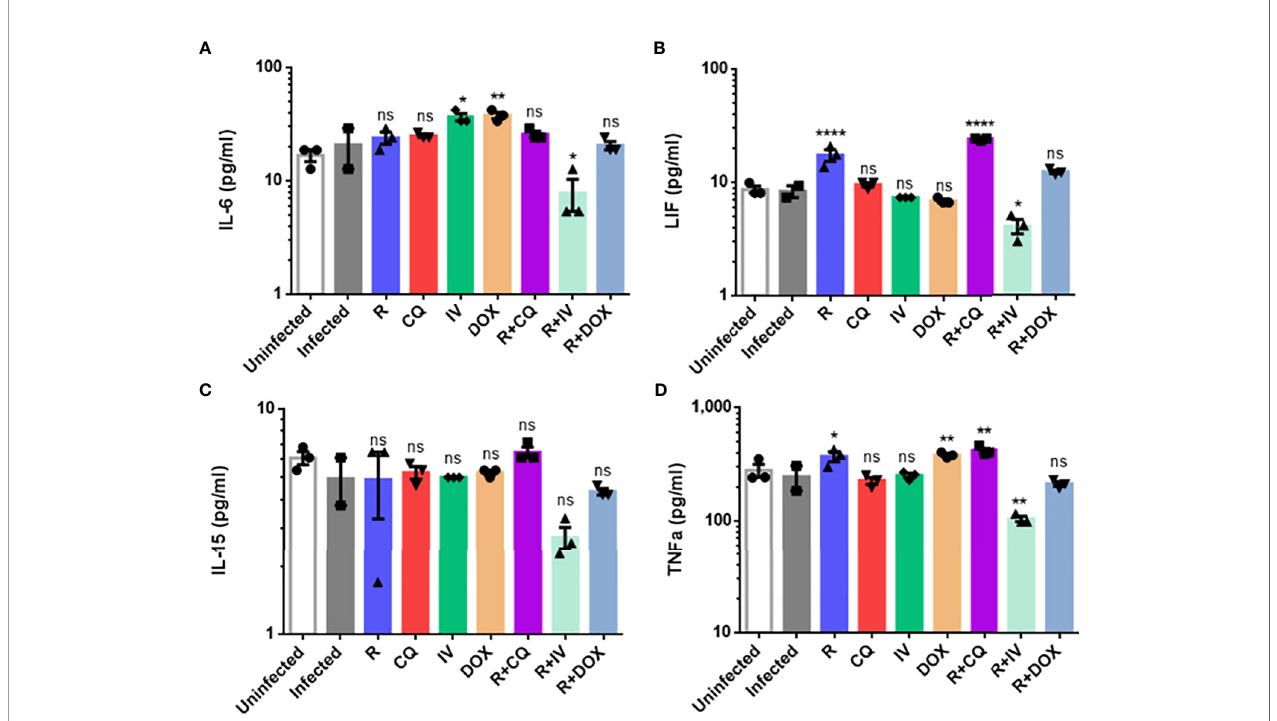
FIGURE 3 | Cytokine protein expression pro fi les of monotherapy versus combination therapy against MHV infection of RAW264.7 macrophages. Remdesivir (R), chloroquine (CQ), ivermectin (IV) and doxycycline (DOX) treatments were evaluated. Cytokine protein levels (pg/ml) of (A) IL-6, (B) leukemia inhibitory factor or LIF, (C) IL-15, (D) TNF- a were quanti fi ed using the Myokine 5-Plex Mouse ProcartaPlex Panel in drug-treated infected samples compared to controls (uninfected cells, and infected but untreated cells). IL-10 cytokine levels were below the detection limit, and were thus omitted. The data represent means and SEM from triplicate experiments. Statistical signi fi cance was determined by one-way ANOVA with Dunnett ’ s multiple comparison against the infected untreated control, and denoted by asterisks: * P < 0.05; ** P < 0.01; **** P < 0.0001. ns, not statistically signi fi